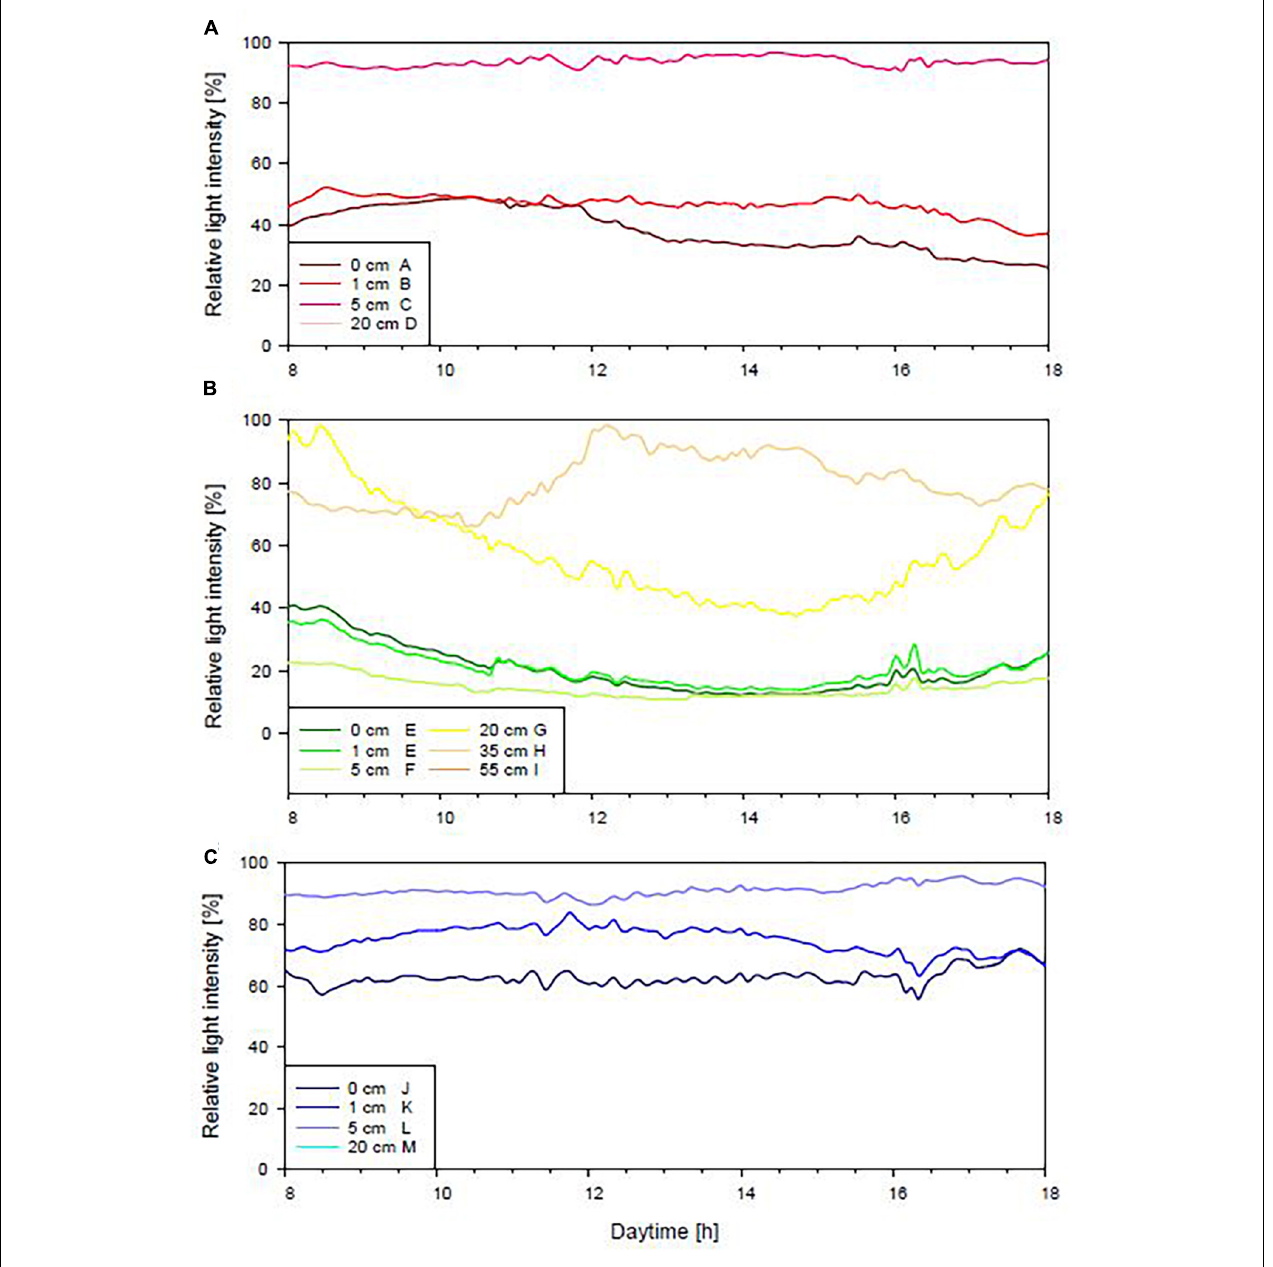
FIGURE 3 | Relative light intensity compared to loggers placed above canopy [%] in Phyllophora crispa (A) , Posidonia oceanica (B) or at similar water depth on rocky substrates (C) . Displayed are mean values observed during light hours from 8 am to 6 pm. References (100%) are included in the legend for the display of statistical differences. No statistical differences are indicated by the same letter, significant statistical differences by different